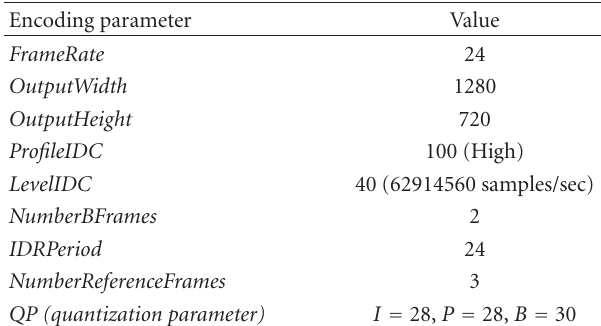
Table 1: Encoding parameters for the selected YouTube video col-